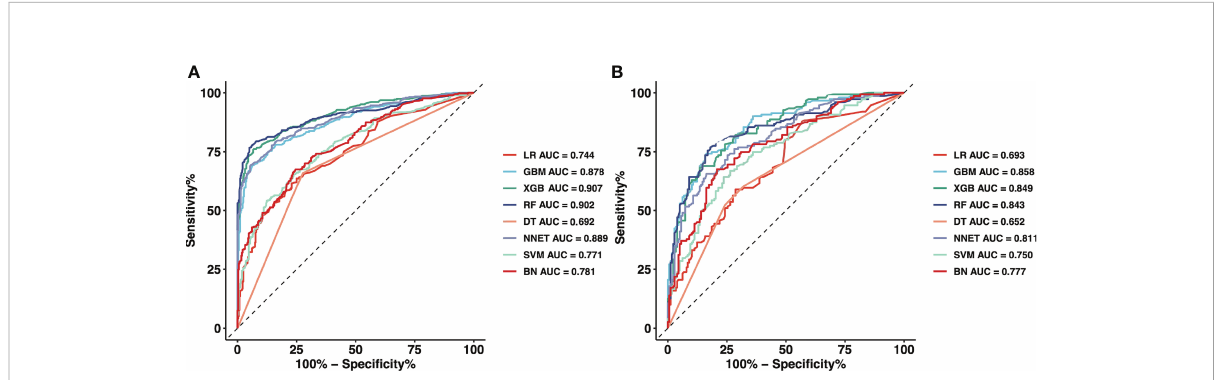
FIGURE 2 The mixed ROC curves of the eight machine learning models for prediction of CLNM. (A) The mixed ROC curves in the training cohort; (B) The mixed ROC curves in the validation cohort. ROC , receiver operating characteristic; CLNM , Central lymph node metastasis; LR , Logistic Regression; GBM , Gradient Boosting Machine; XGB , Extreme Gradient Boosting; RF , Random Forest; DT , Decision Tree; NNET , Neural Network; SVM , Support Vector Machine; BN , Bayesian